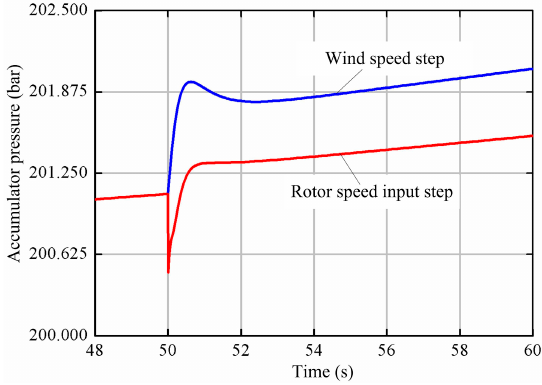
Figure 13. Accumulator pressure.